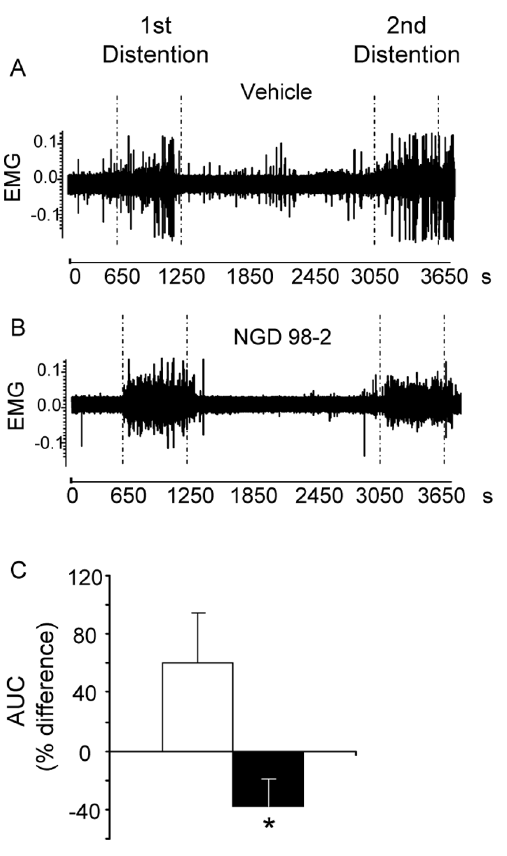
Figure 7. Oro-gastric (og) pretreatment with NGD 9002 blunts repeated tonic colorectal distention (CRD)-induced visceral sensitization response in conscious rats. Rats were chronically implanted with abdominal electrodes and , 10 days later were pretreated og with vehicle or NGD 9002 (0, 10 or 30 mg/kg). After 30 min of habituation and 10 min basal recording, rats were submitted to the 1 st CRD (10 minutes at 60 mm Hg) followed by a 30 min rest and a 2 nd 10 min distention at 60 mmHg. Representative trace of abdominal muscle electromyogram (EMG) of rats pretreated with vehicle (A) or NGD 9002 (B). Percent difference in the area under the curve of contraction (AUC) between the 1 st and the 2 nd dissentions in saline and NGD 9002 treated rats is shown in C. Values are mean and SEM of percent differences between the first and second responses to CRDs of 8–22 rats/group. *p , 0.05 versus vehicle, t-test or ANOVA, Student- Newman-Keuls.